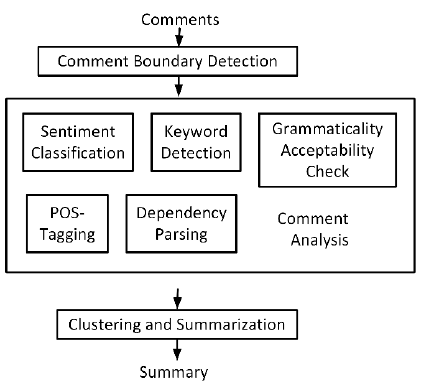
Figure 2. Comment analysis and summarization procedure.